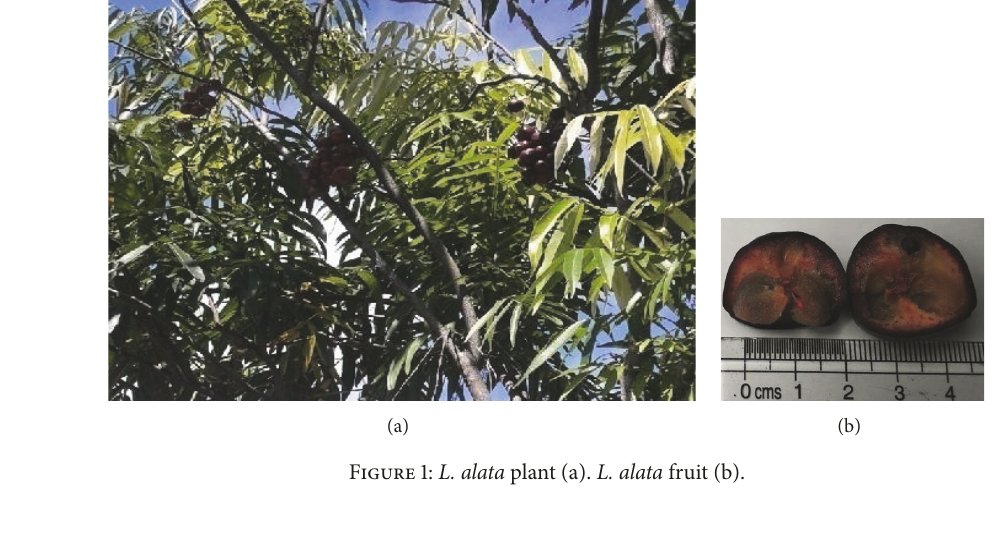
Figure 1: L. alata plant (a). L. alata fruit (b).